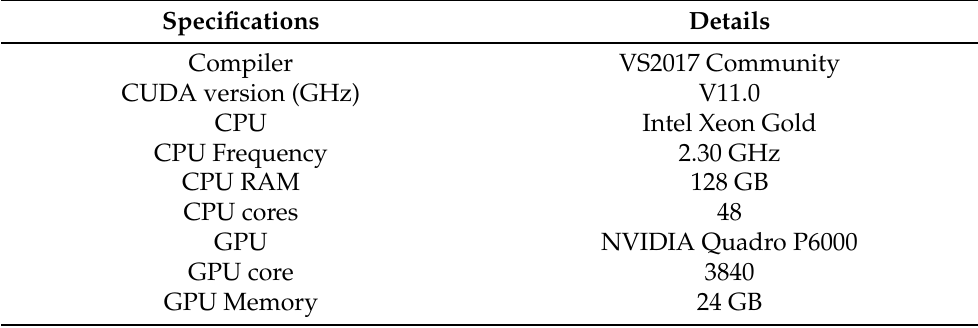
Table 1. Specifications and details of the workstation computer.